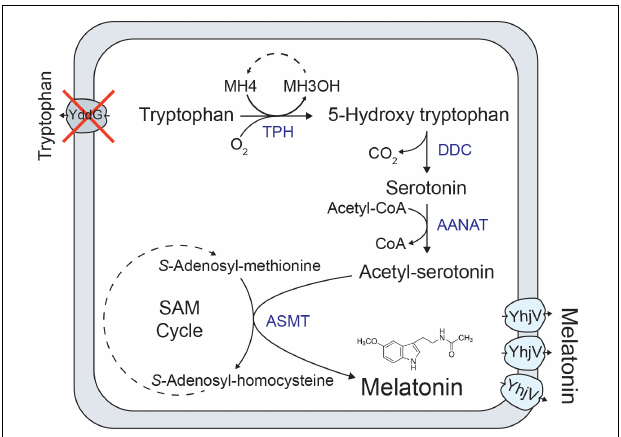
FIGURE 1 | Melatonin biosynthesis pathway from tryptophan. Heterologous genes introduced into E. coli are indicated in blue. Cross indicates deletion of a native E. coli gene. Heterologous genes introducing 5-Hydroxytryptophan decarboxylase (DDC), aralkylamine N-acetyltransferase (AANAT), tryptophan hydroxylase (TPH); a pterin-4-alpha-carbinolamine dehydratase (PCD), and acetylserotonin O-methyltransferase (ASMT) expressed using constitutive promotors. Transporters related to tryptophan uptake (YddG) and melatonin efflux (YhjV) are also